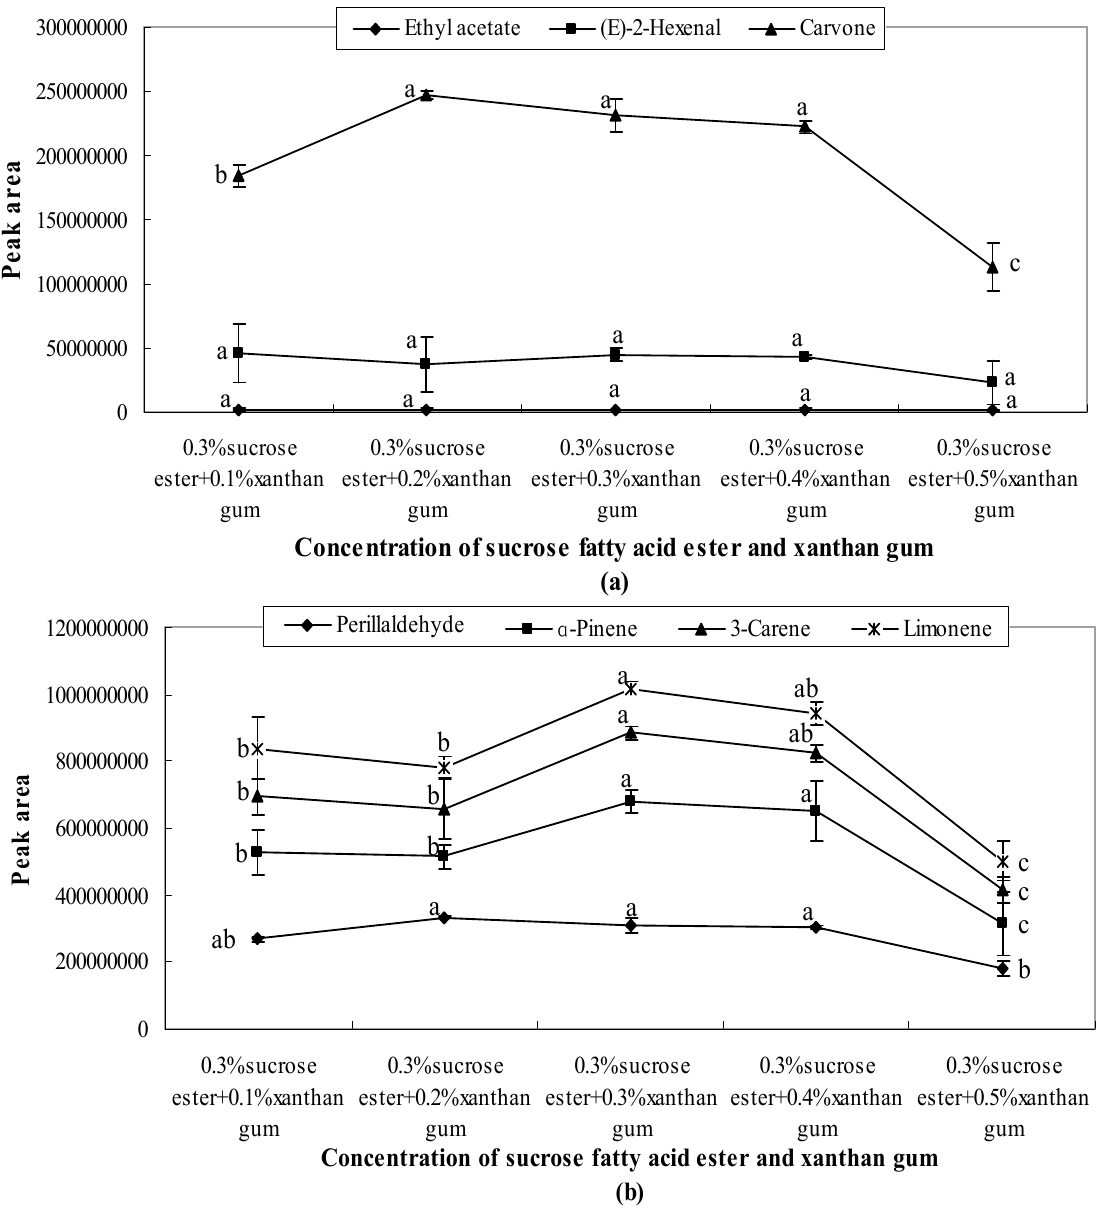
Figure 7. Effects of sucrose fatty acid ester and xanthan gum on the release of ethyl acetate, ( E )-2-hexenal, carvone, perillaldehyde ( a ) and α -pinene, 3-carene, limonene ( b ). Significant differences ( p < 0.05) between different concentrations are performed by letters on the same polylines. Where the letters on the same polyline are the same, there is no significant difference between different concentrations.